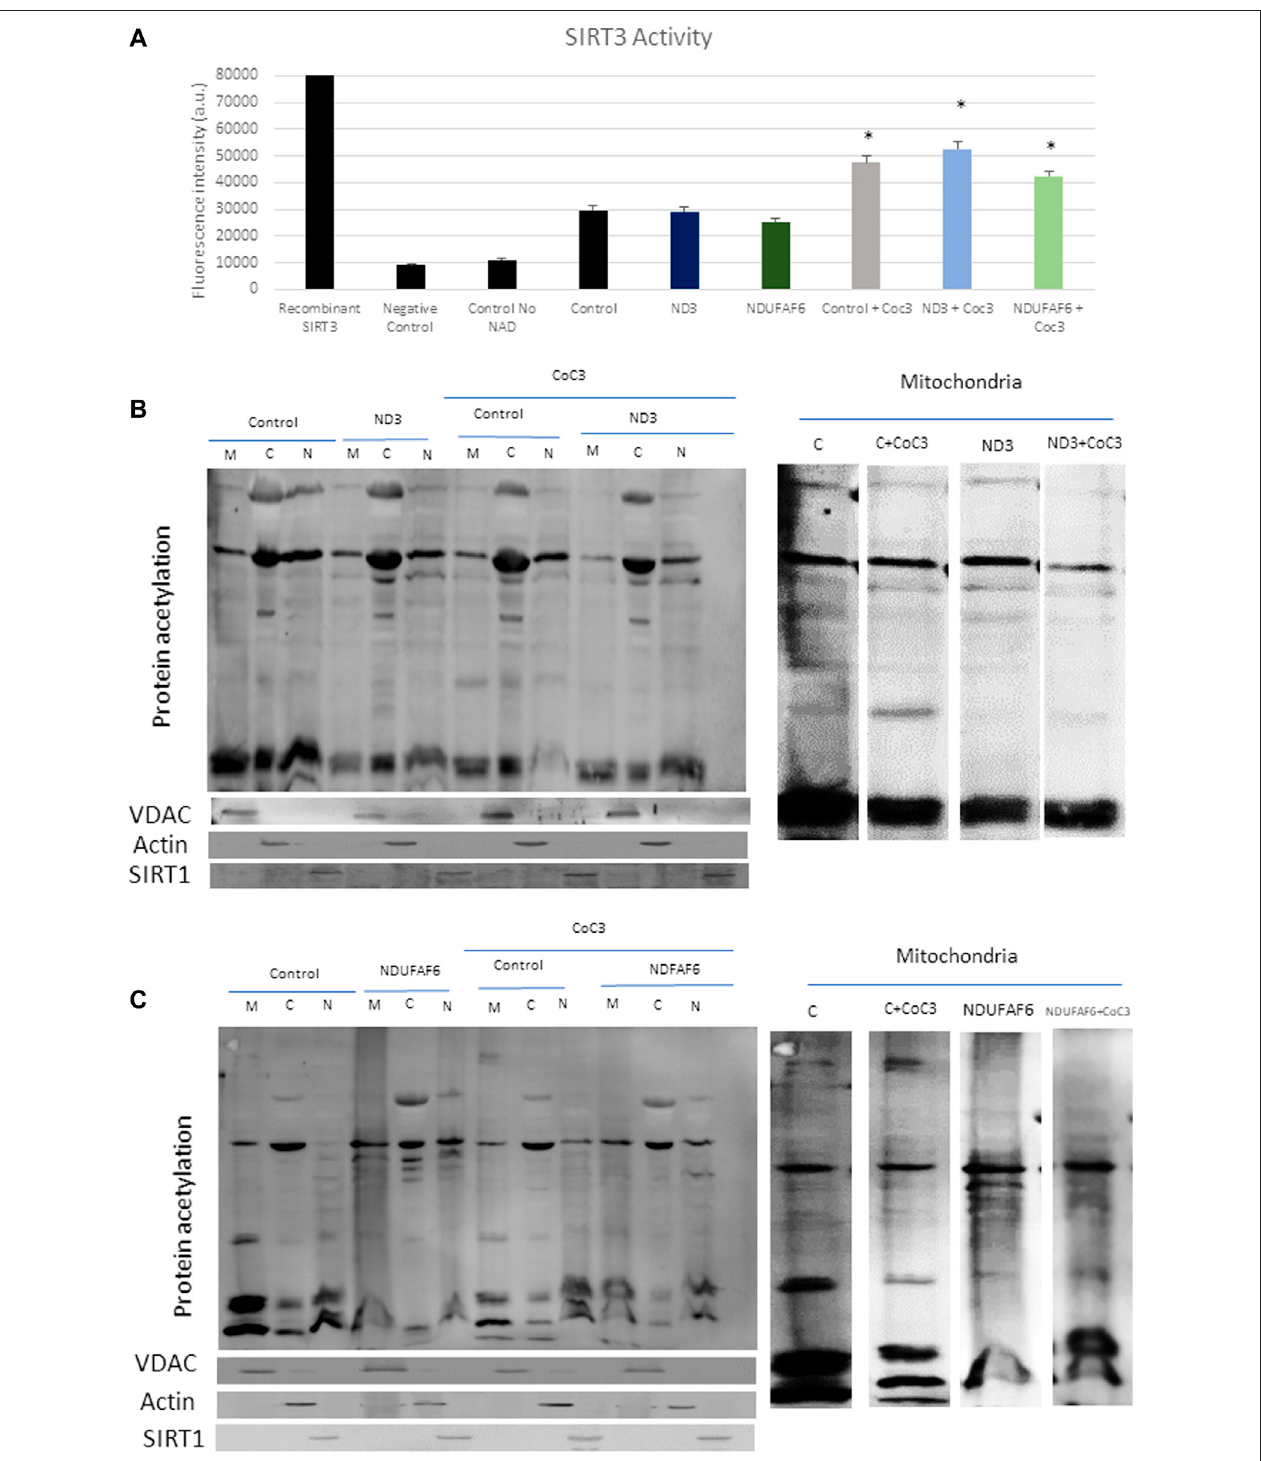
FIGURE 7 | Effect of CoC3 on SIRT3 activity in control and mutant cell lines. SIRT3 activity was determined in mutant mtND3 and NDUFAF6 cells. Total SIRT3 activity was evaluated using the SIRT3 Activity Assay Kit (Fluorometric) from Abcam (A) . Pure SIRT3 protein was used as positive control, and no-enzyme and no-NAD (SIRT3 cofactor) samples as negative controls. Fluorescence was measured using a POLARstar Omega plate reader. Western blot of total protein acetylation in mutant mtND3 (B) and mutant NDUFAF6 (C) fi broblasts. Protein acetylation was assessed in mitochondria, cytoplasm and nuclei fractions. VDAC was used as mitochondrialproteinmarker;Actinwasusedascytoplasmproteinmarker;SIRT1wasusedasnuclearproteinmarker.Banddensitometry isshownin Supplementary FigureS9 .Fibroblastsweretreatedfor7dayswithCoC3treatment:1 μ MPterostilbene,5 μ Mnicotinamide,1 μ Mribo fl avin,1 μ Mthiamine,1 μ Mbiotin,5 μ Mlipoicacid and 1 μ M L -carnitine. * = p < 0.01 between untreated and treated fi broblasts.